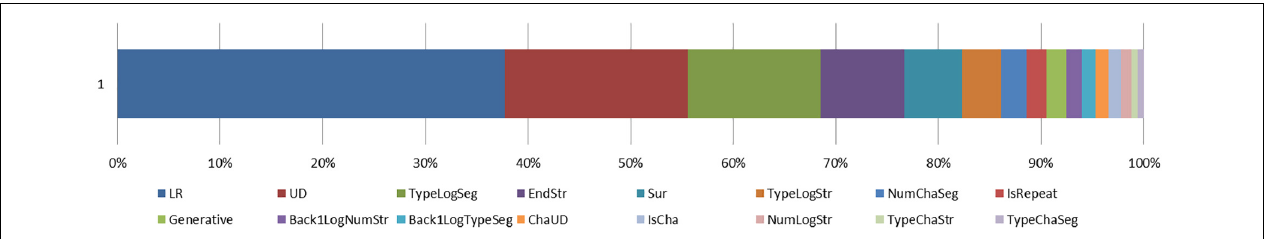
FIGURE 4 | Relative contributions of the different predictors to the